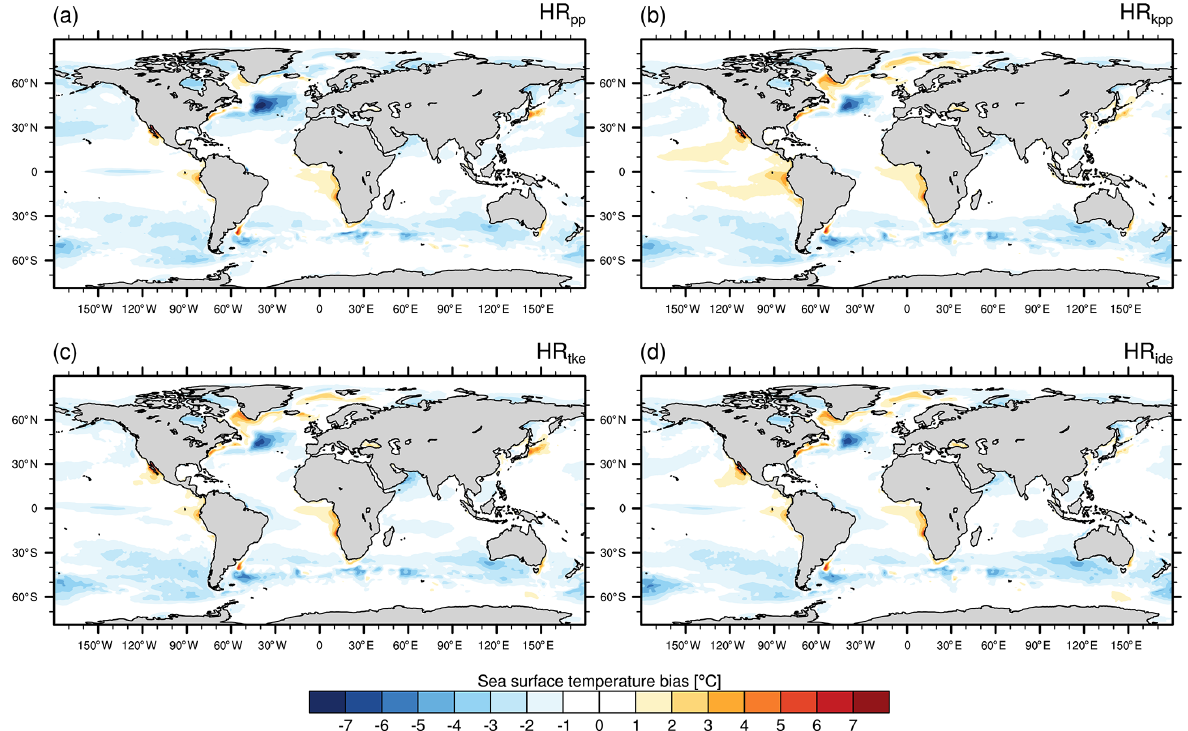
Figure 2. Time-averaged sea surface temperature bias of MPI-ESM1.2-HR minus EN4 (1945–1955) for (a) HR pp , (b) HR kpp , (c) HR tke , and (d) HR ide